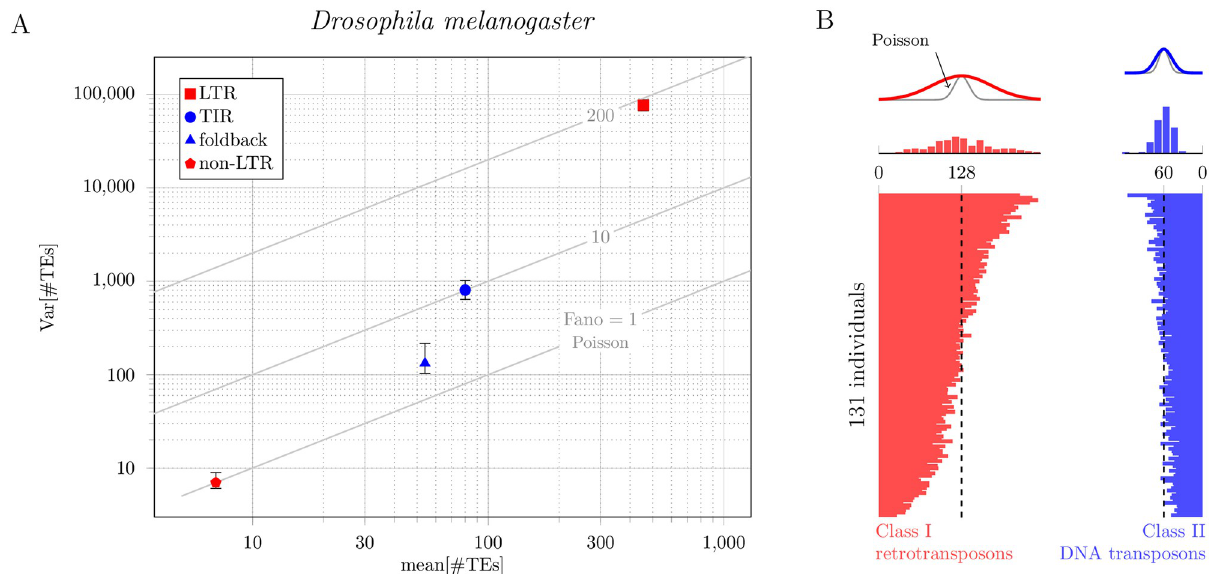
Fig 2. Empirically observed distributions of TE copy number in a Drosophila melanogaster population. A: Mean-variance plot of TE copy number for 131 individuals compared to theoretical expectation (Fano = 1, Poisson diagonal line). For each of four different families of TEs, the index of dispersion is in the range 1 < Fano ½ n � < 200 . Vertical bars show 95% bootstrap confidence intervals. B: TE copy number for 131 D. melanogaster individuals. TE counts are separated by class (red, Class I, retrotransposon; blue, Class II, DNA transposon). https://doi.org/10.1371/journal.pone.0270839.g002 Comparison of the marker locations and histograms in Figs 1 and 2 with the gray lines labelled Poisson shows that in both species, Mimulus guttatus and Drosophila melanogaster , the population distribution of TE load is overdispersed (the variance of TE load is greater than the mean TE load). In D. melanogaster , this overdispersion is greater for Class I TEs (retrotran- sposons) with an RNA intermediate than Class II TEs (DNA transposons) (Fig 2B). The corre- sponding Fano factors, given by Eq (10), are 16 and 2.7, respectively (see Table 1). Fig 1A shows that overdispersion of TE load is even more pronounced in M. guttatus . In this case, the Fano factors are 61 for Class I TEs (red symbols: LINE, SINE and LTR), and 646 for Class II TEs (blue symbols: CACTA, Helitron, Tcl-Mariner, PIF-Harbinger, hAT and MULE). Fig 1B shows the estimated number of Class I and II TEs in each of the 164 lines of M. guttatus (hori- zontal bar graph). In both cases, the variance (width of red and blue histograms) is far greater than the variance in classical models of TE population genetics (gray curves). Taken together, Figs 1 and 2 show that in both species ( M. guttatus and D. melanogaster ) and for both classes